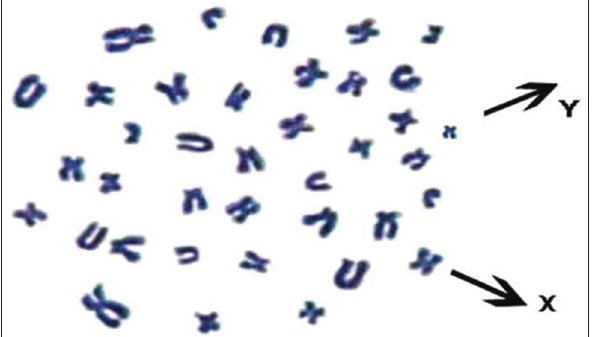
Figure-1: Giemsa stained metaphase spread of indigenous Boar (2n = 38, XY)